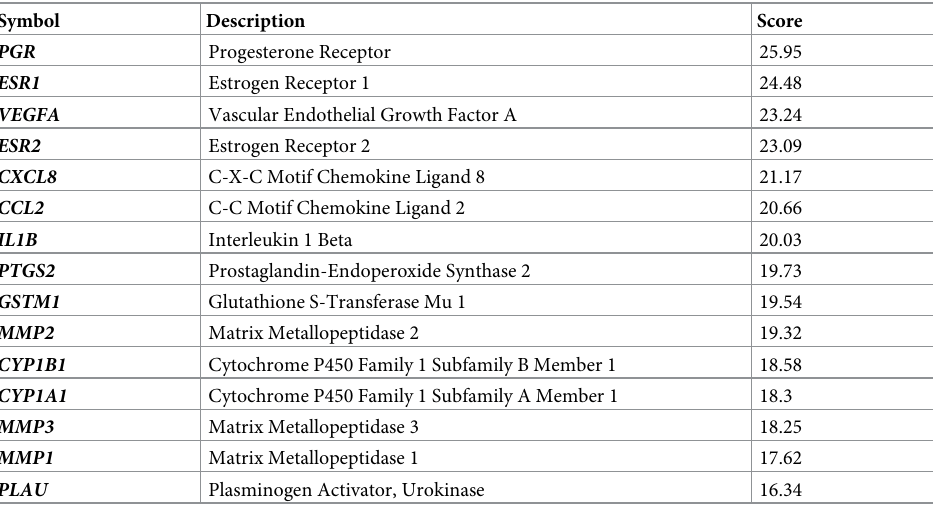
Table 2. Genes found in both the compound-target network and MalaCards.